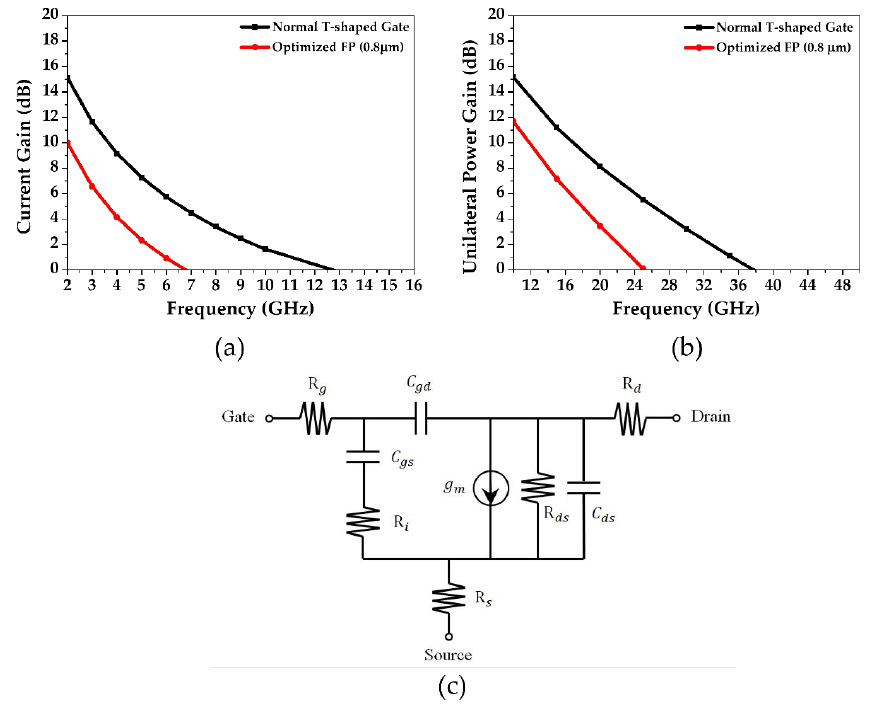
Figure 6. ( a ) Current gain; ( b ) unilateral gain of the optimized FP structure and normal T-shaped gate structure; ( c ) small signal equivalent circuit of the HEMT. structure; ( c ) small signal equivalent circuit of the